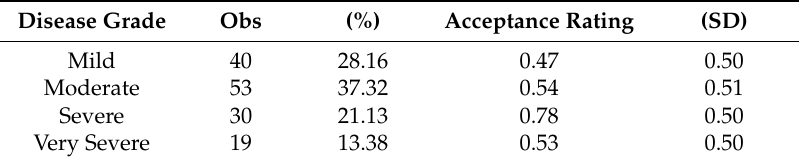
Table 3. WTP acceptance rating by disease